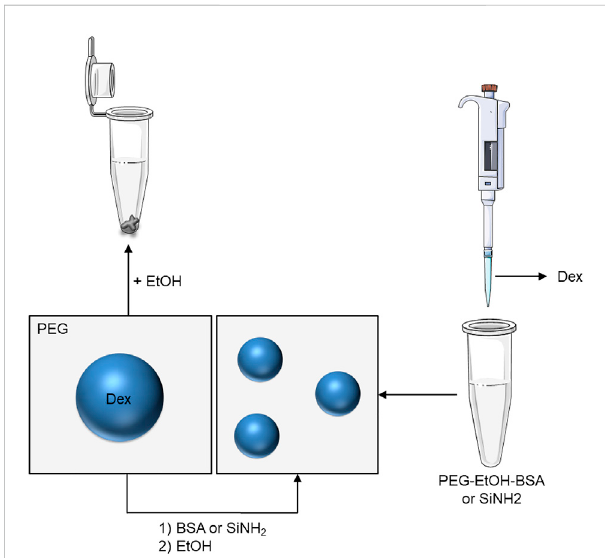
SCHEME 1 Schematic representation of the production of stable droplets fromwater-in-wateremulsionsuponsolventshifting.1 st method(left): ethanol is poured in the emulsion containing proteins or particles, 2 nd method (right): A Dex-rich dispersion is poured into aqueous PEG that also contain ethanol, proteins or particles. In both cases, stable droplets that no longer coalesce form.